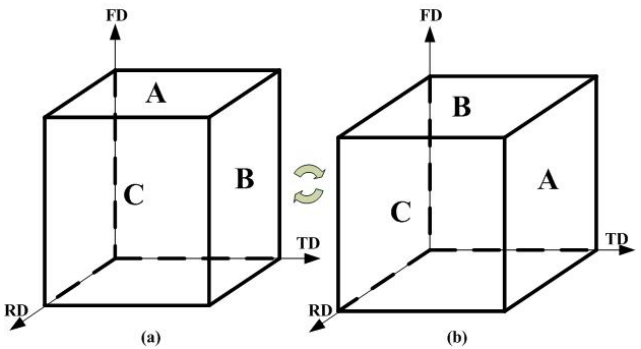
Figure 3. Schematic drawings of the high strain rate biaxial forging (HSRBF) process ( a ) odd number passes ( b ) even number passes.